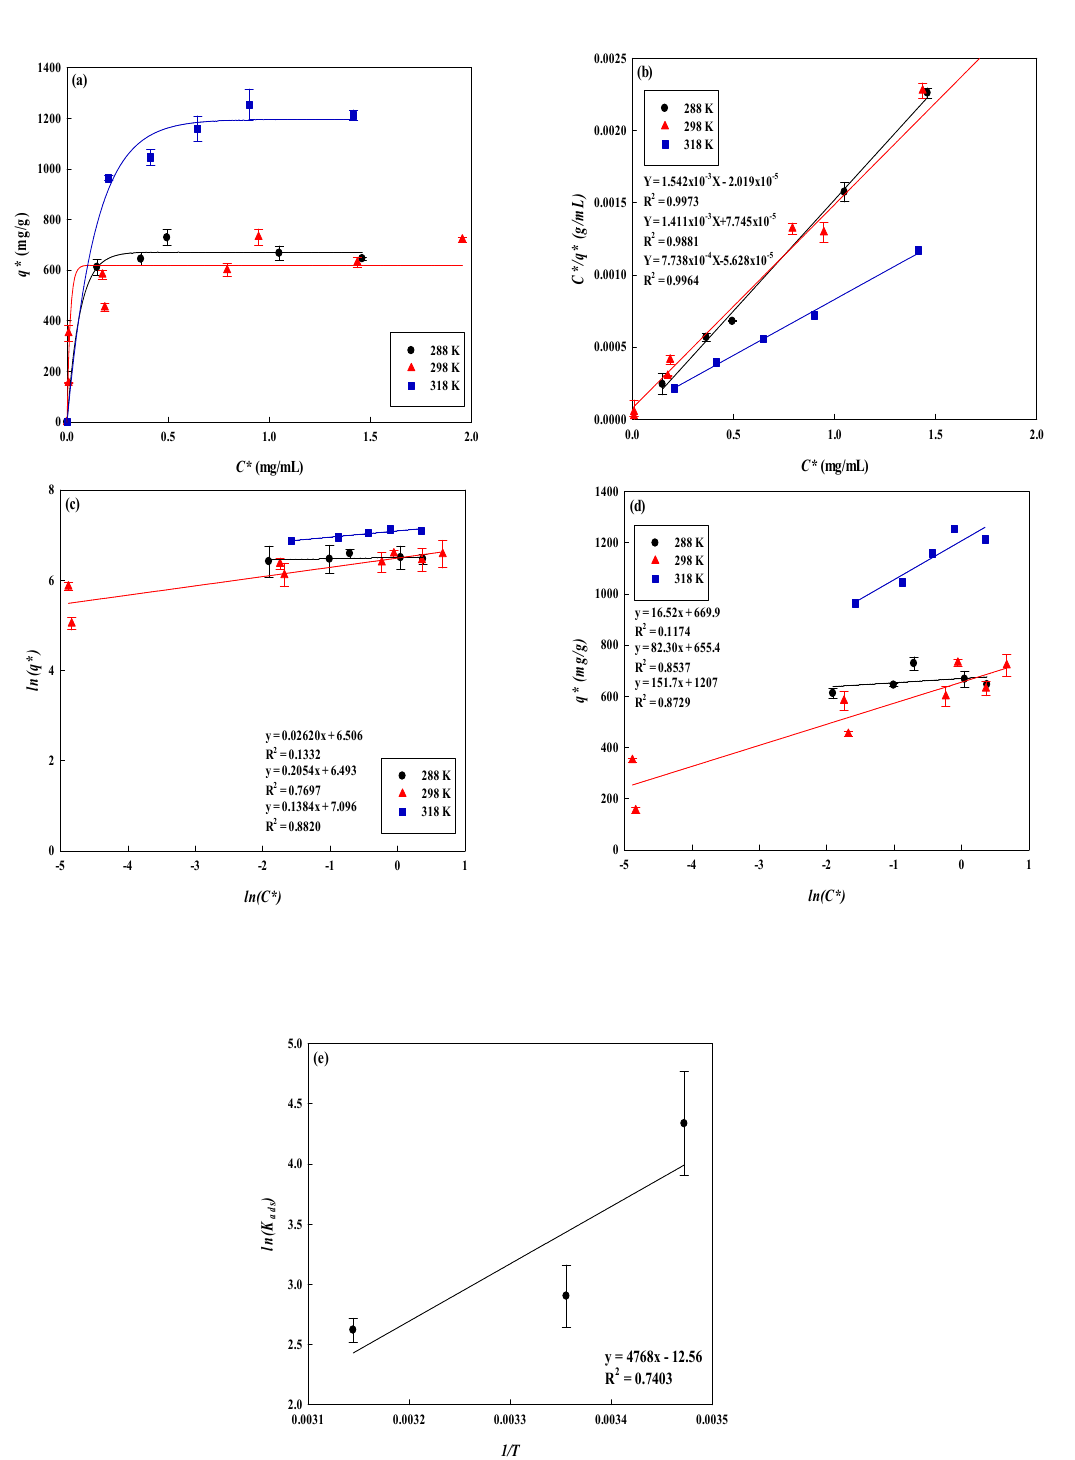
Figure 8. ( a ) Effect of temperature on the equilibrium isotherm curves for the adsorption of lysozyme on P-COOH-CS-RG19 nanofiber membrane, ( b ) Langmuir model plot of C*/q* against C* , ( c ) Freundlich model plot of ln(q*) against ln(C*) , ( d ) Temkin model plot of q* against ln(C*) , and ( e ) Van ’t Hoff plot for the adsorption of lysozyme on P-COOH-CS-RG19 nanofiber membrane. ∆ G o can be calculated from the K ∆ G o < 0 is spontaneous L , and the result shows that Table 4. Equilibrium and thermodynamic parameters calculated using equilibrium isotherm models for determining the adsorption; plotting ln( K L ) against ( 1/T ) as shown in Figure 8e, it can be obtained, ∆ H o < 0 adsorption behavior of P-COOH-CS-RG19 nanofiber membrane for lysozyme. (corresponding to − 3.96 × 10 4 J/mol). The results showed that it is an exothermic reaction and the higher the temperature, the higher the adsorption capacity, and ∆ S o > 0 means Temperature